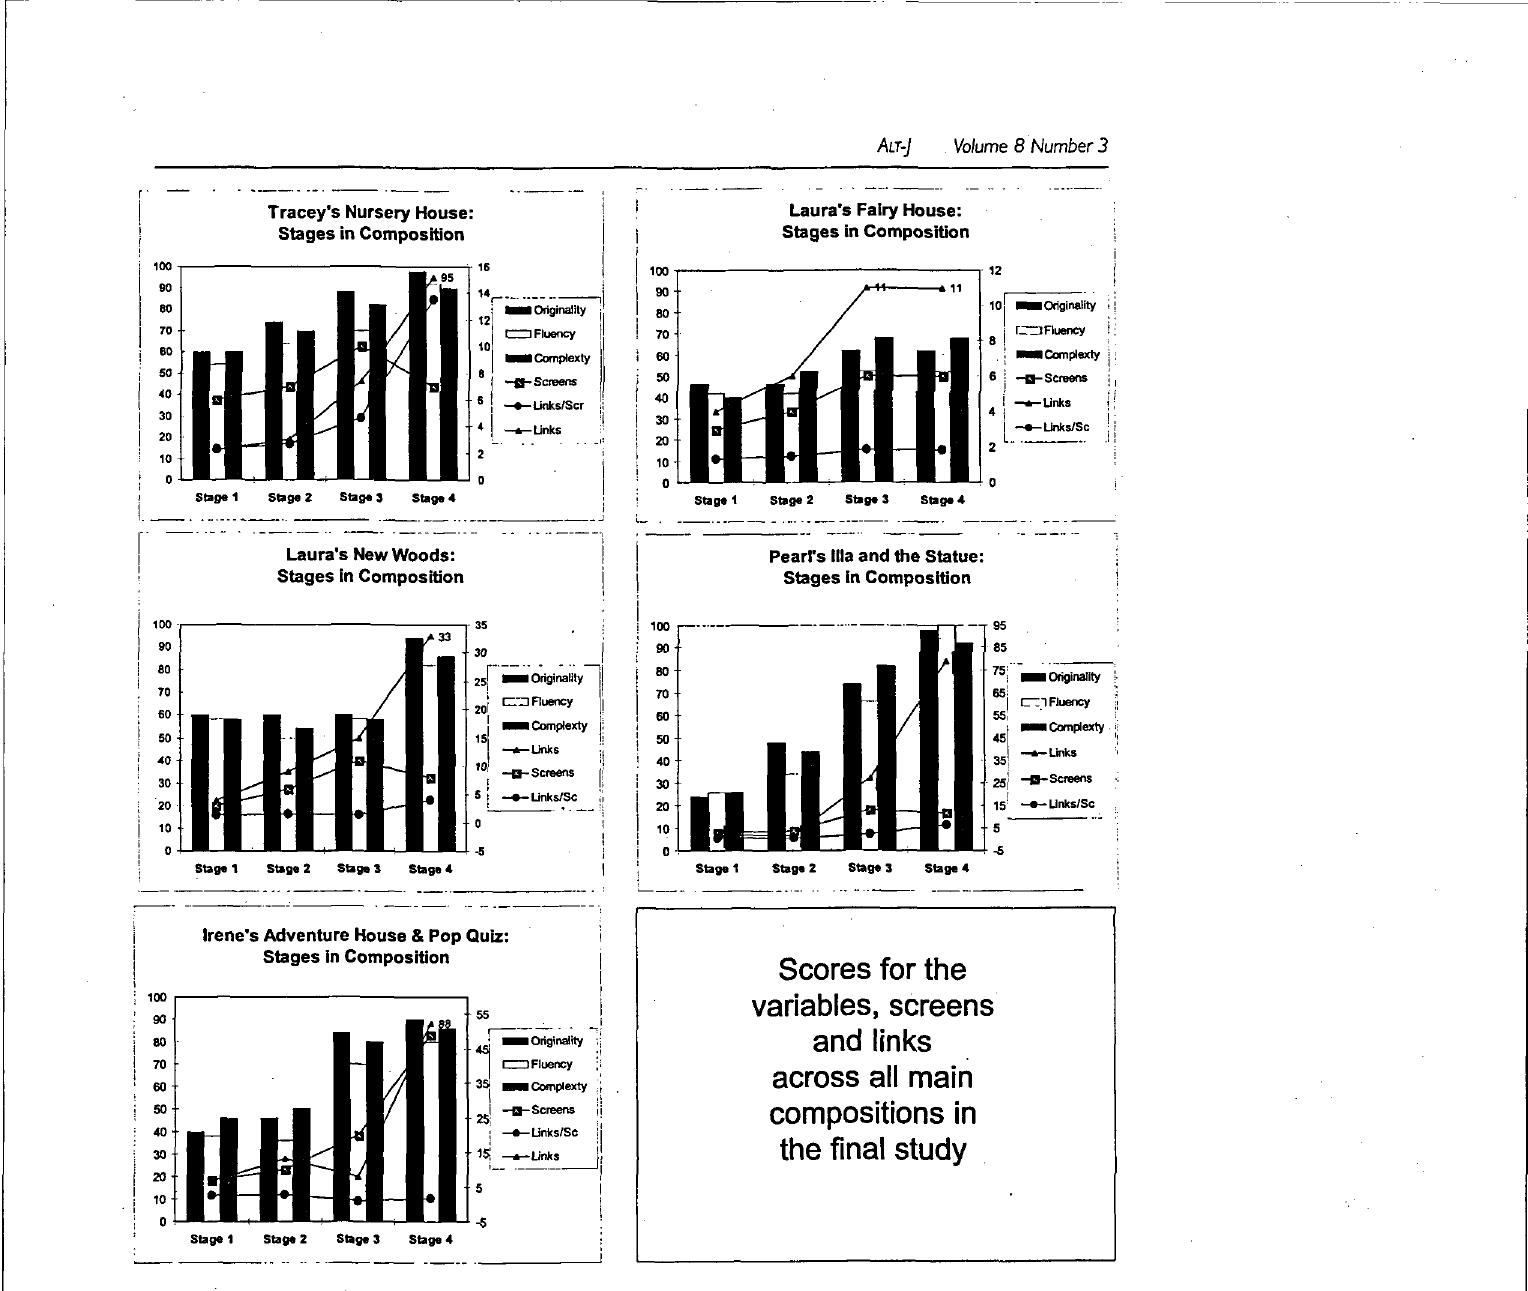
Figure I: Scores for the variables, links and screens across all